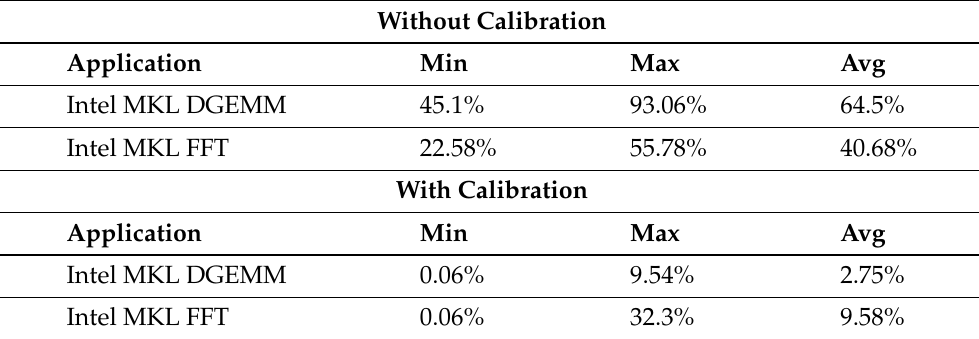
Table A2. Percentage error of MPSS against ground-truth dynamic energy profiles with and without calibration on the Intel Xeon Phi co-processor (Figure 1) for Intel MKL DGEMM and Intel MKL FFT applications.